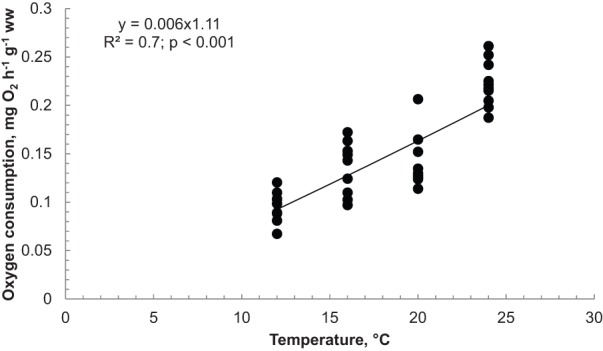
Effect of different acclimation temperatures on the oxygen consumption rate of Hemigrapsus crenulatus. A liner relationship was observed between oxygen consumption (mg O2 h−1 g−1 ww) and increased acclimation temperature. n=10 per treatment.